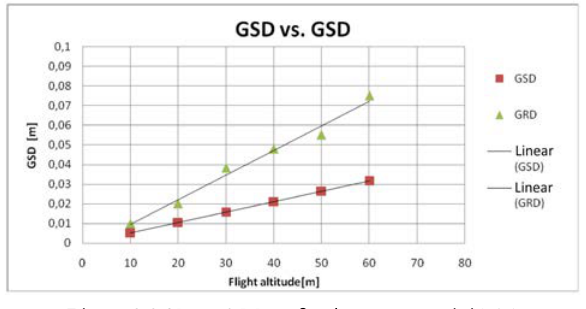
Figure 6.GSD vs GRD - for the camera miniMCA All differences between analysed cameras in the GRD parameter are caused by different array size and different focal length of investigated